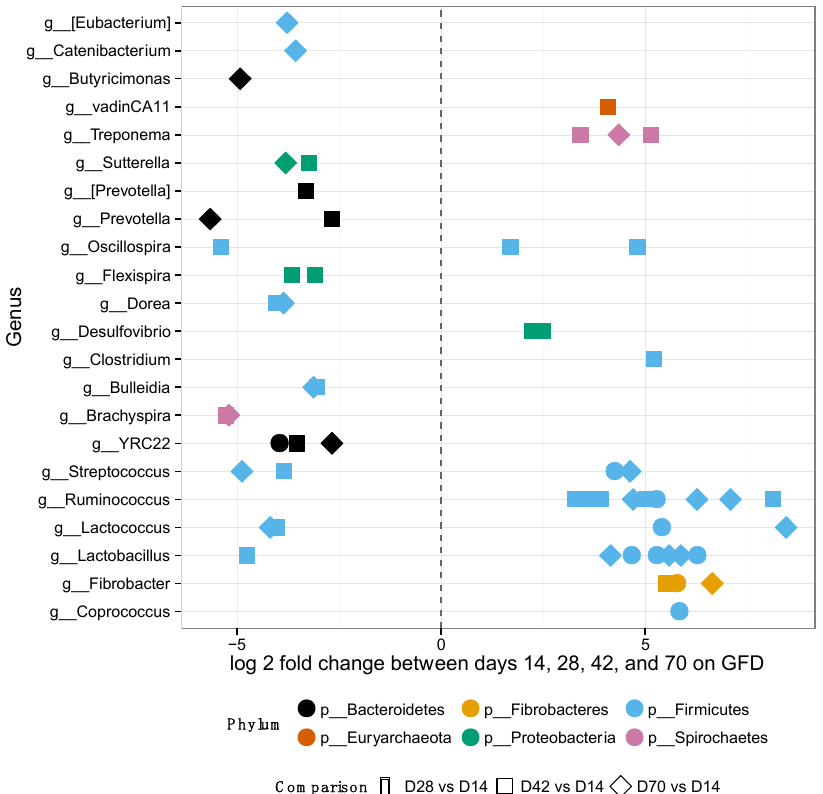
Figure 4. Differentially abundant features in GS macaques while on GFD. One hundred forty ‐ five significantly different OTUs belonging to each genus out of 1212 tested were identified in GS macaques while on GFD. Overall increase of beneficial bacterial groups is seen in GS macaques while on GFD. Most of the significant features were from the phylum Firmicutes , particularly the family Ruminococcaceae .